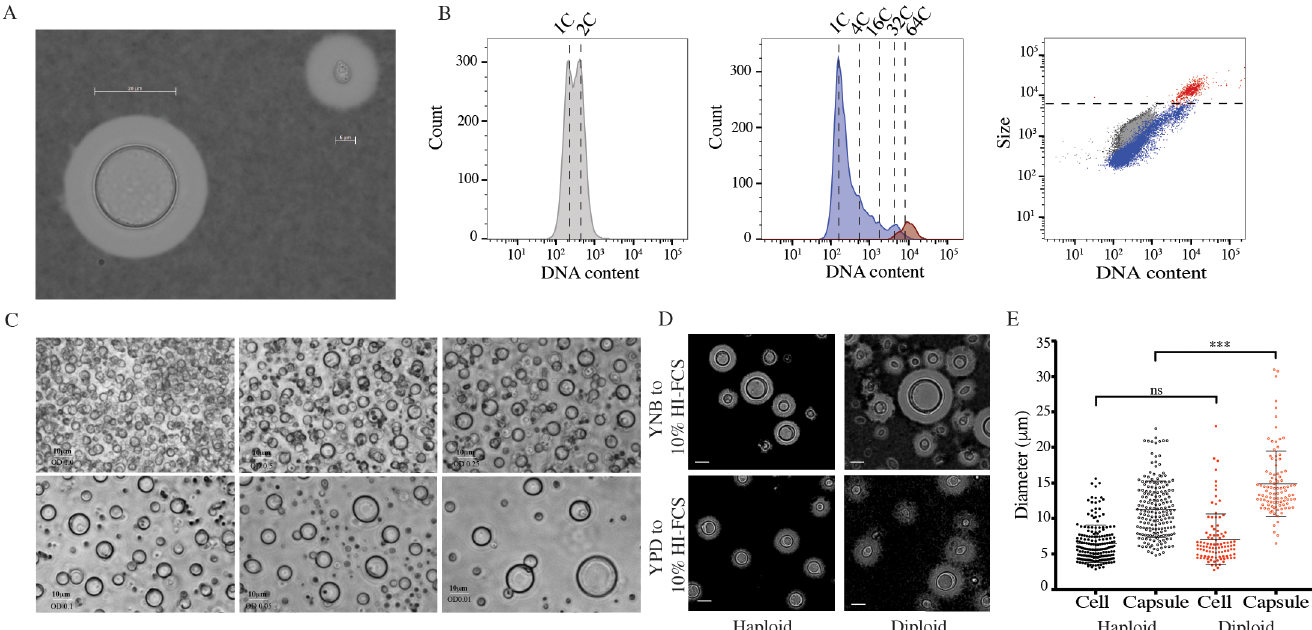
Fig 1. Titan cells can be induced in vitro and have all the properties of in vivo induced cells. H99 haploid cells pre-grown in YNB and incubated in 10%HI-FCS at 37˚C, 5%CO 2 for 3 days. Resulting colonies were A) counterstained with India ink to reveal capsule and B) fixed and stained for DNA content relative to haploid and diploid controls. Left panel shows YNB grown haploid control. Middle panel shows total induced population (blue). In addition, induced cells were passaged through an 11 μ m filter to enrich for large cells (red). Right panel shows all three populations. C) H99 haploid cells were pre-grown in YNB and incubated in 10%HI-FCS at the indicated OD 600 at 37˚C, 5%CO 2 for 3 days. Scale bar = 10 μ m. D,E) H99 haploid and KN994B7#16 diploid cells pre-grown in either YNB or YPD were inoculated into 10%HI-FCS at OD 600 = 0.001, (37˚C, 5%CO 2 , 3 days) and then counterstained with India ink and analysed. Representative micrographs (D) and diameters for > 200 cells excluding or including capsule (E) are shown. Significance was assessed using Mann Whitney U ( (cid:3)(cid:3)(cid:3) p < 0.0001).